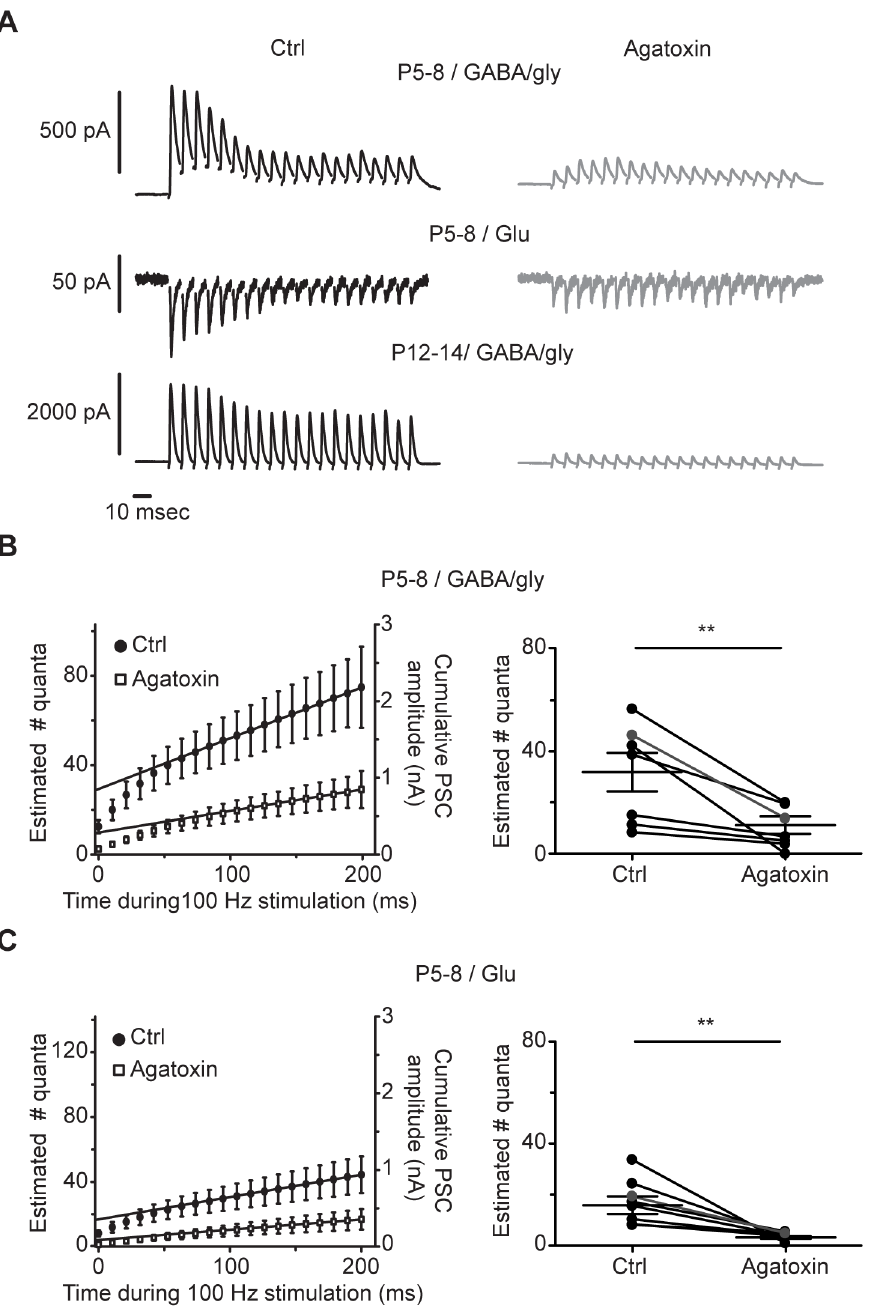
Figure 5. P/Q-type VGCCs influence quantal release for GABA/gly and glutamate component. A ) PSC traces in control and with v - agatoxin IVA. GABA/gly and glutamate traces were recorded from the same neuron (P6). GABA/gly traces below from P13 tissue. Each trace shown is the average of 10 responses. B–C ) Estimated quantal number for GABA/gly component ( B ) and glutamate component ( C ) before and after application of v -agatoxin IVA at P5–8, calculated from the pooled data on the left and from individual cells on the right. The last 8 data points from the curve were fitted by linear regression and extrapolated to time zero to estimate the readily releasable pool. The cumulative amplitude found by the linear regression was divided by the average amplitude of the sPSC (for GABA/gly 29.0 6 6.1 pA in control and 26.8 6 4.7 pA after v -agatoxin IVA; for glutamate 21.4 6 2.6 pA in control and 20.0 6 2.9 pA after v -agatoxin IVA. Cell in A shown in gray.